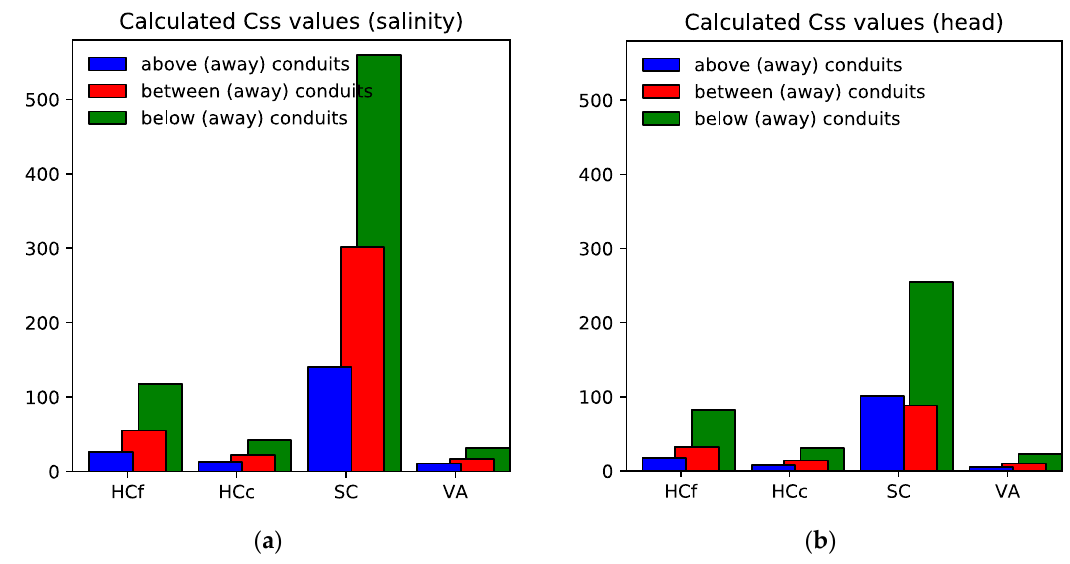
Figure 6. Calculated Css values of all parameters with respect to: ( a ) Salinity simulations in the fractured medium, away (j = 25) from de two conduits (layer n. 6, 13, 21); ( b ) Head simulations in the fractured medium, away (j = 25) from the two conduits (layer n. 6, 13, 21).